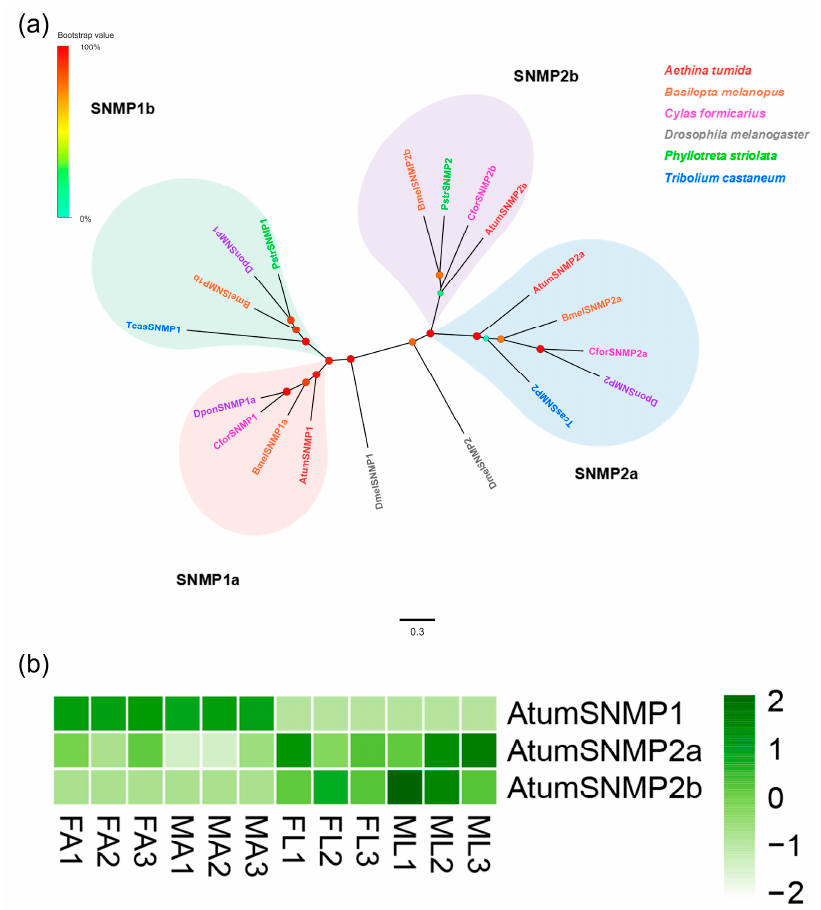
Figure 4. Analyses of putative sensory neuron membrane proteins (SNMPs) in A. tumida . ( a ) Maximum-likelihood tree of putative SNMPs. Circles at the branch nodes represent bootstrap values based on 1000 replicates. Scale bar represents the 0.3 amino acid substitutions per site. The different clades are highlighted as pink, blue, green and purple, respectively. ( b ) Heatmap of SNMPs based on antennae and forelegs transcriptome data in A. tumida . FA, female antennae; MA, male antennae; ML, male forelegs; FL, female forelegs. The transcript abundance was measured by FPKM-values.